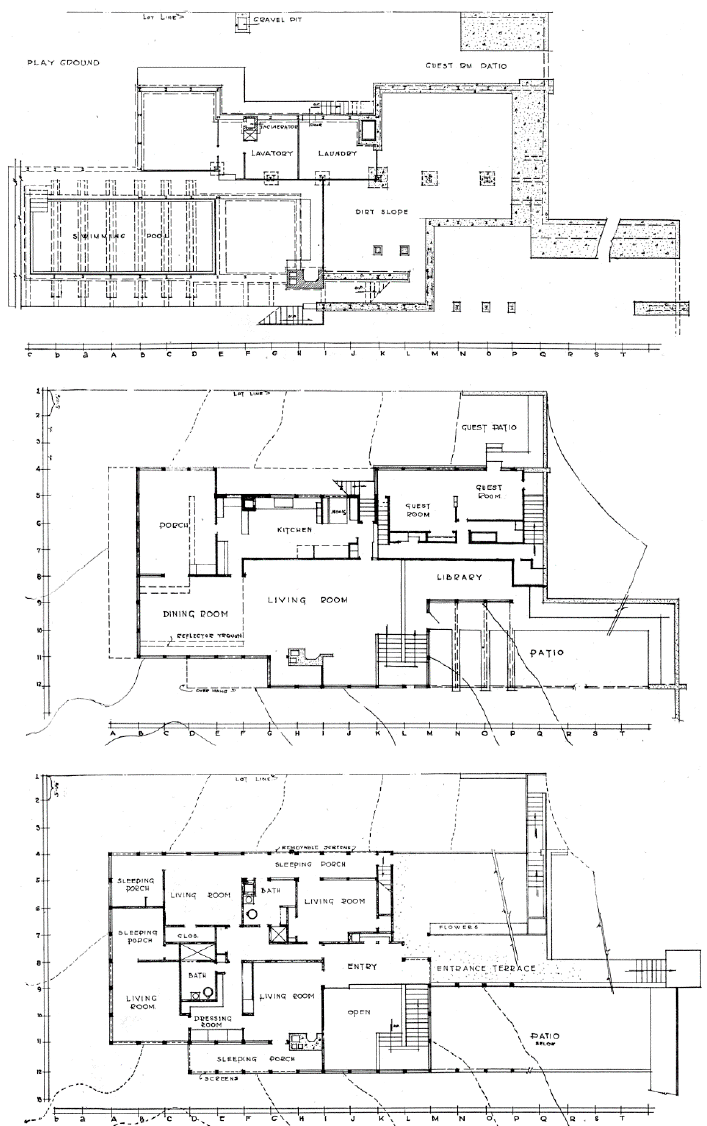
Figure 4. Richard Neutra, Lovell Health House, Los Angeles, 1927–1929. Basement Plan,